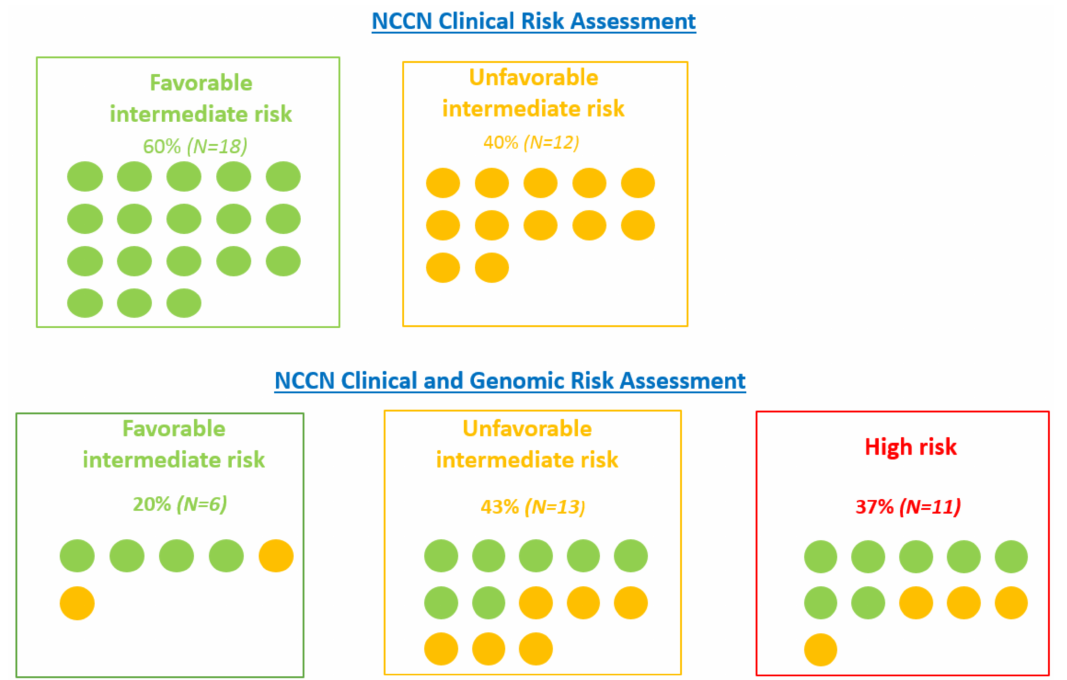
Figure 1. Clinical and genomic risk stratification. Classification based on NCCN clinical risk group alone and combined NCCN clinical and genomic risk group (GPS). The combined risk group (based on NCCN risk group and genomic score) was provided in the report by Genomic Health. Each round represents a